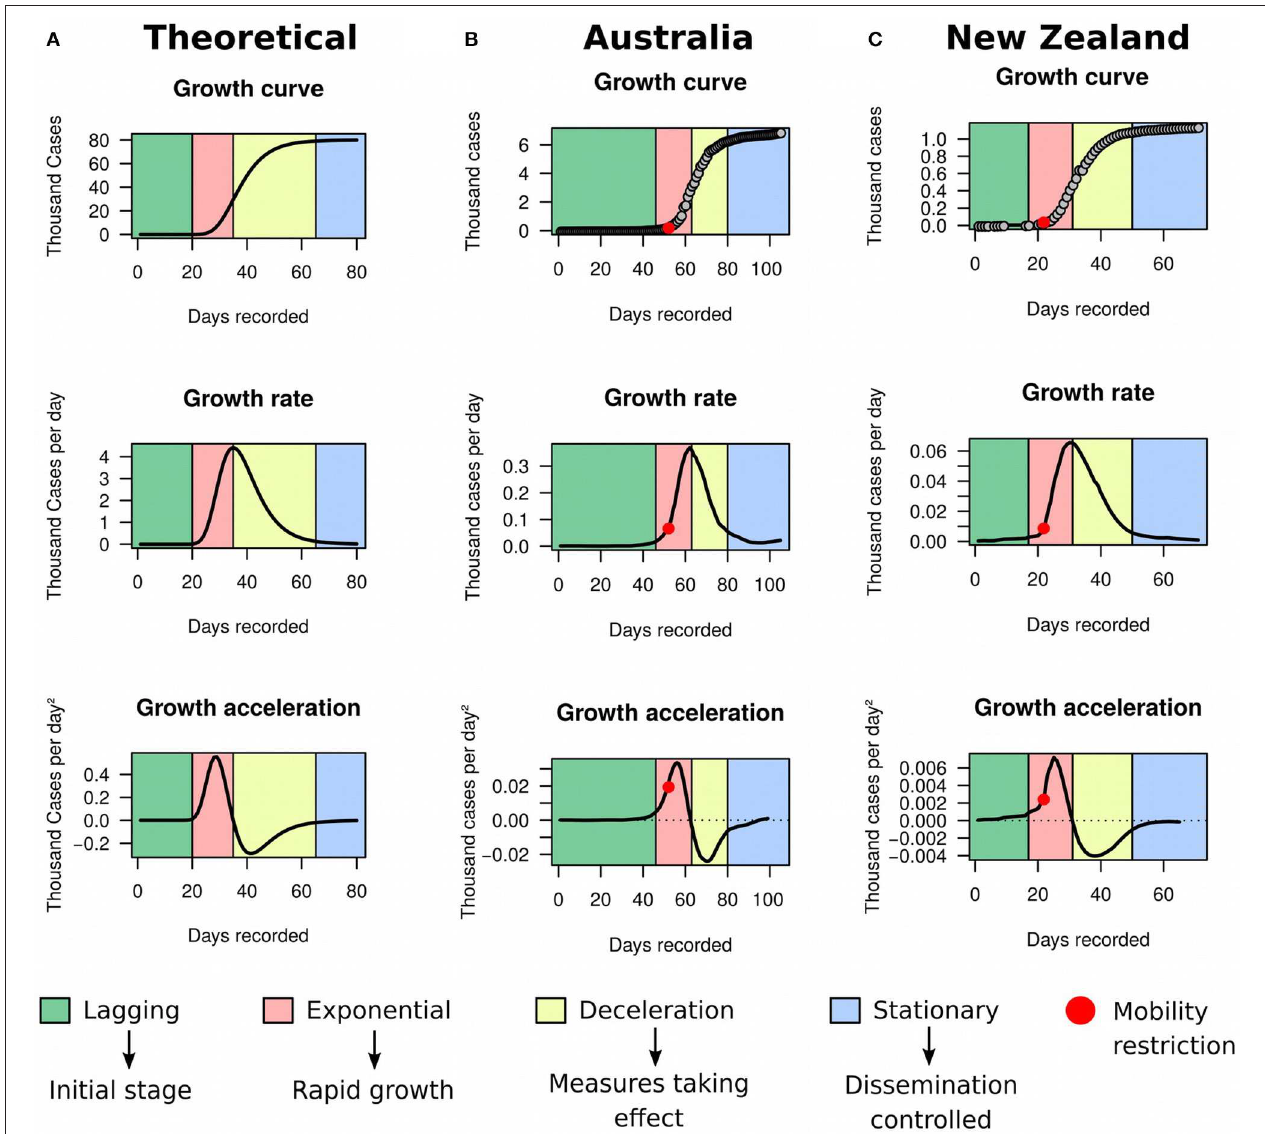
FIGURE 1 | Growth rate and acceleration in Australia and New Zealand. (A) Theoretical model exemplified by simulated data using a three-parameters Gompertz model with an asymptote at 80,000, growth coefficient of 0.15, inflection time at 35, and time ranging from 1 to 80. (B) Fitted curves for Australia between January 25th and May 8th 2020. (C) Fitted curves for New Zealand between February 28th and May 8th